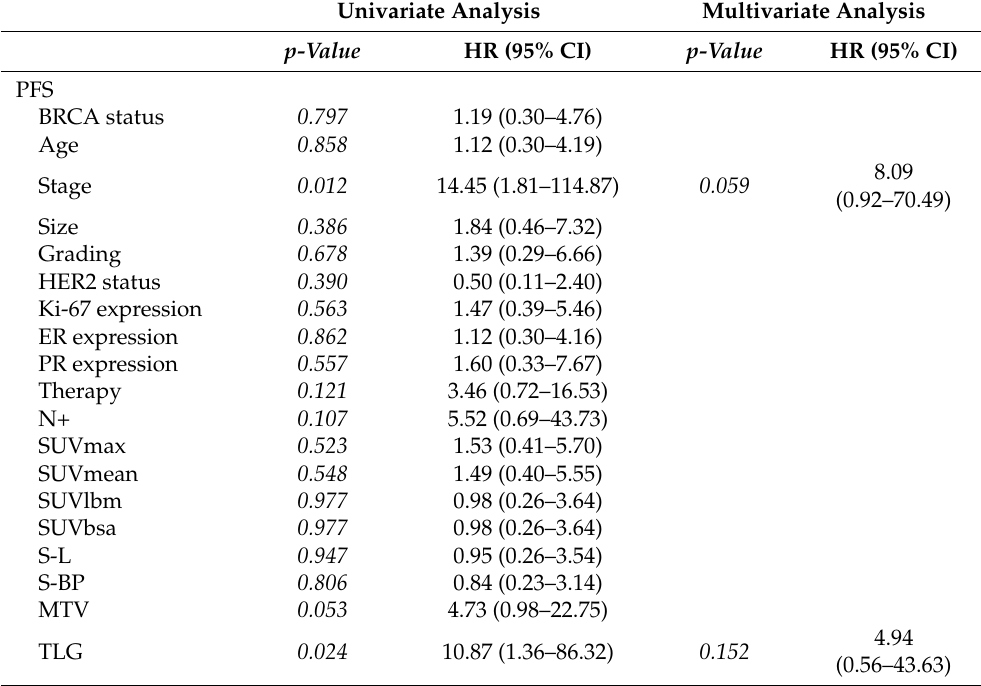
Table 5. Univariate and multivariate analyses with clinicopathological and [ 18 F]FDG PET/CT semiquantitative parameters for PFS and